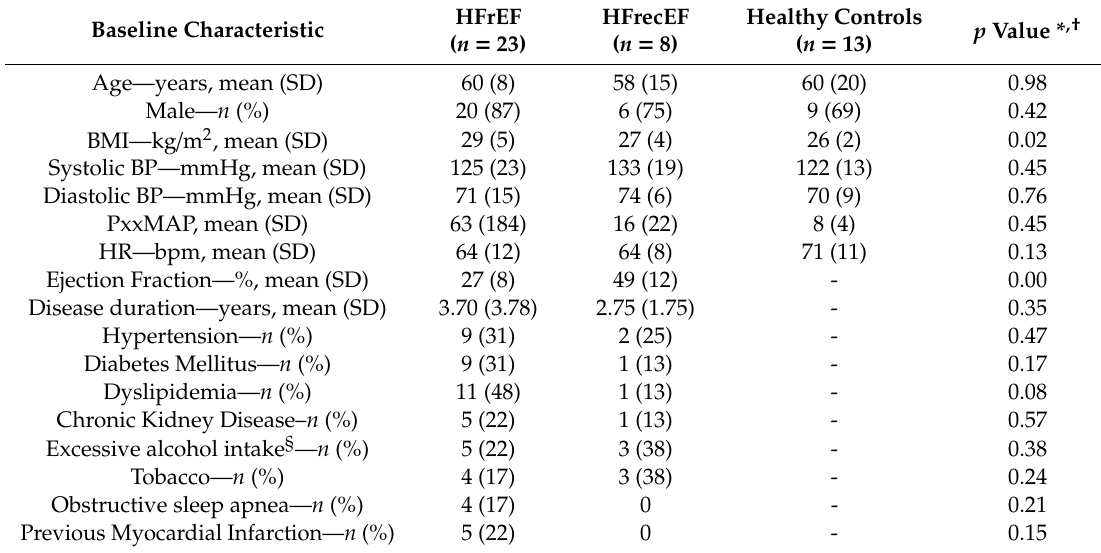
Table 1. Comparison of baseline characteristics of heart failure with reduced (HFrEF) patients, recovered (HFrecEF) controls, and healthy